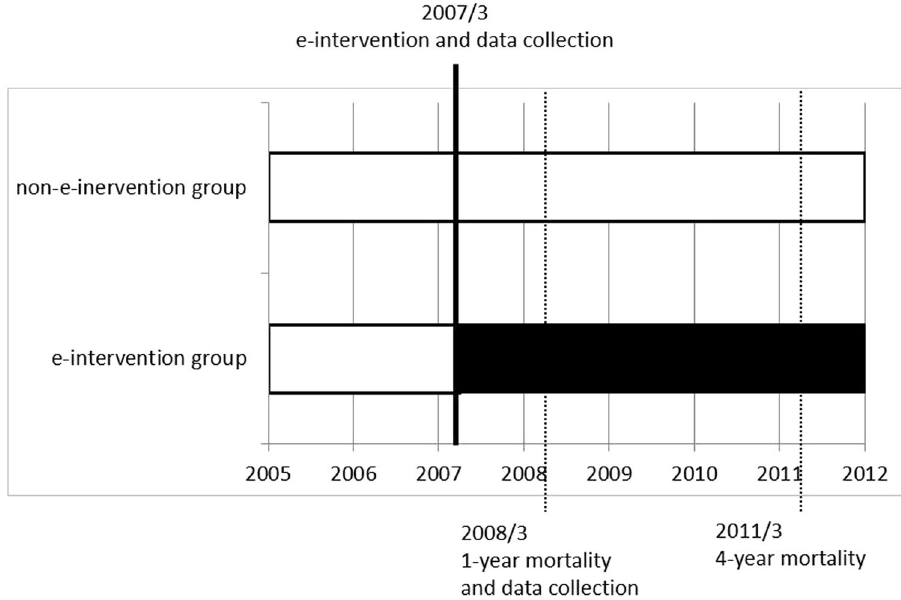
Figure 4. The time regimens of the study groups classified by